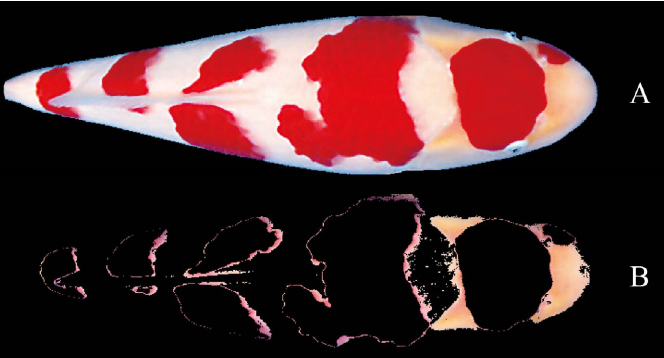
Figure 4. An example of color groups rendered separately. The BP group ( A ) represents all body pixels, and the PRP group ( B ) represents pale red pixels in body coloration.